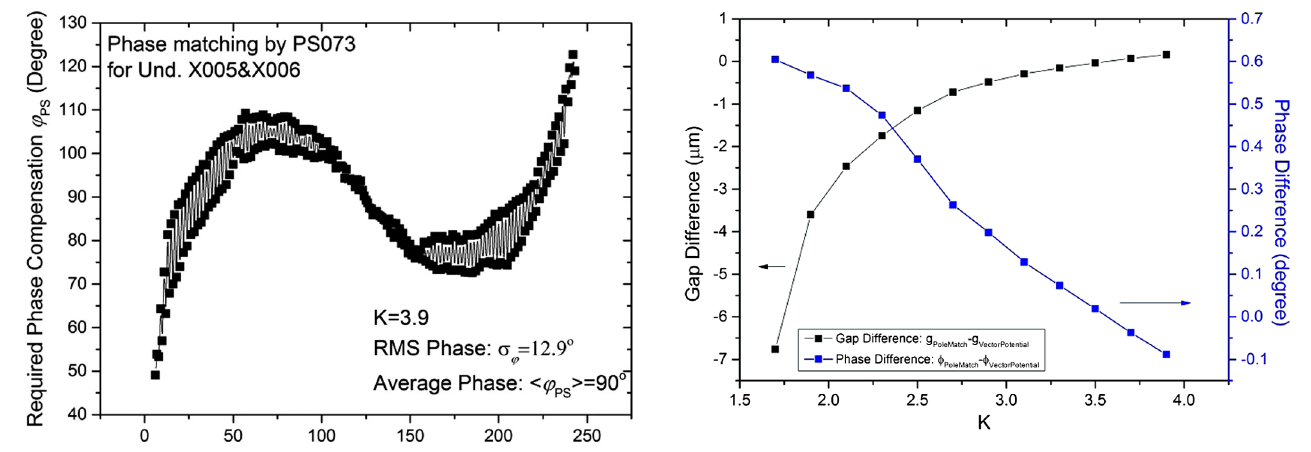
FIG. 10. Comparison between the results of two matching criteria. The black curve shows the difference of the required phase shifter gap, the blue curve the phase difference of phase